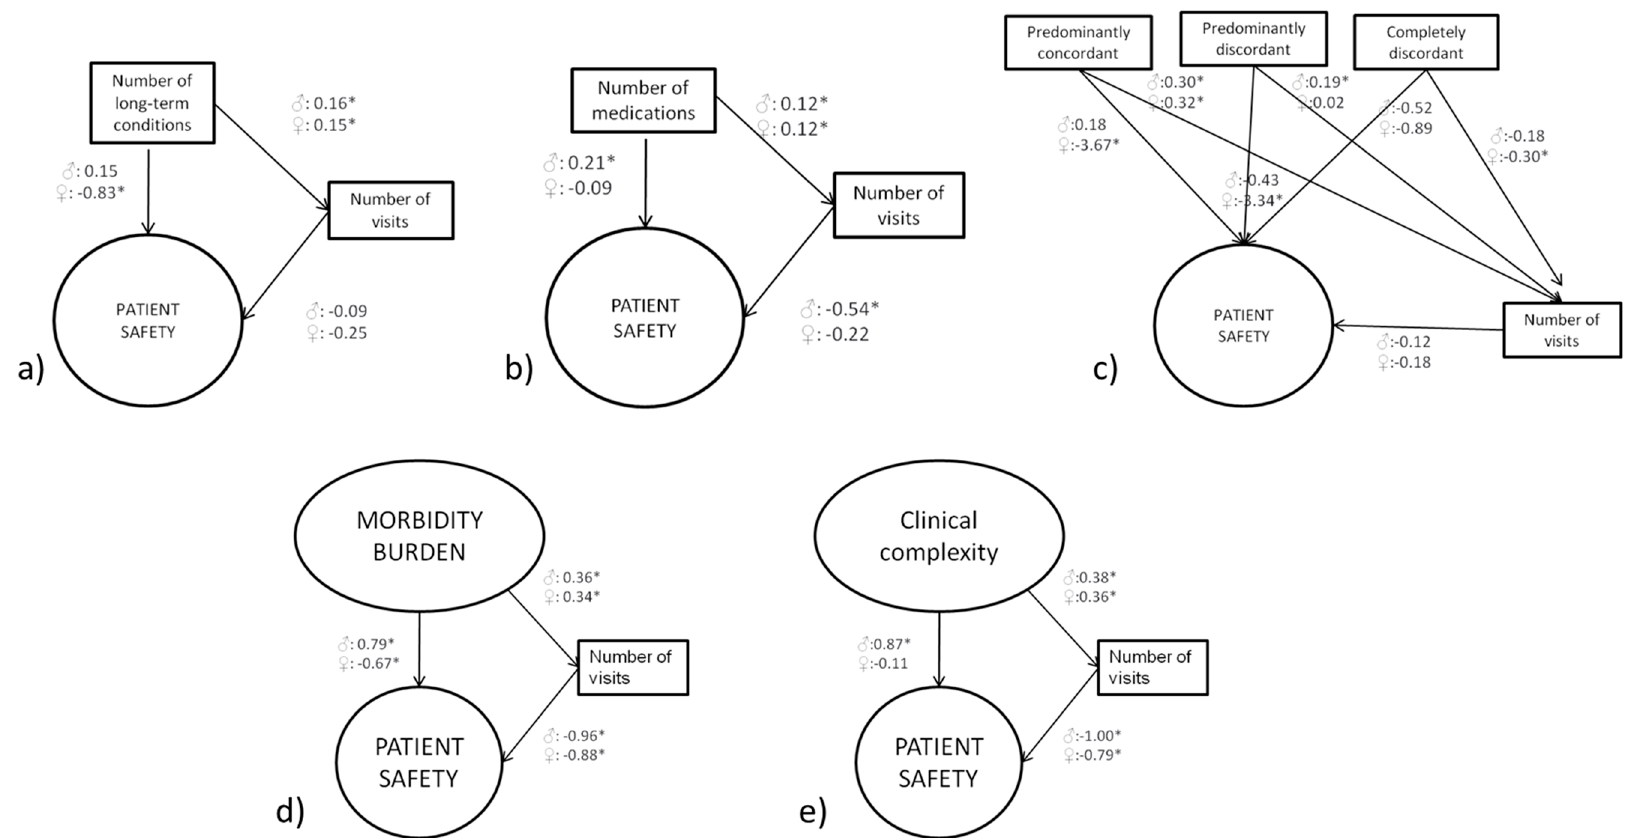
Figure 2. Association between multimorbidity and related constructs and patient safety. ( a ) Association between the number of conditions, patient safety and number of visits in men and women. ( b ) Association between the number of medications, patient safety and number of visits in men and women. ( c ) Association between level of discordance among conditions, patient safety and number of visits in men and women. ( d ) Association between morbidity burden, patient safety and number of visits in men and women. ( e ) Association between the clinical complexity, patient safety and number of visits in men and women. Statistically significant associations ( p < 0.05) are noted with an asterisk (*).